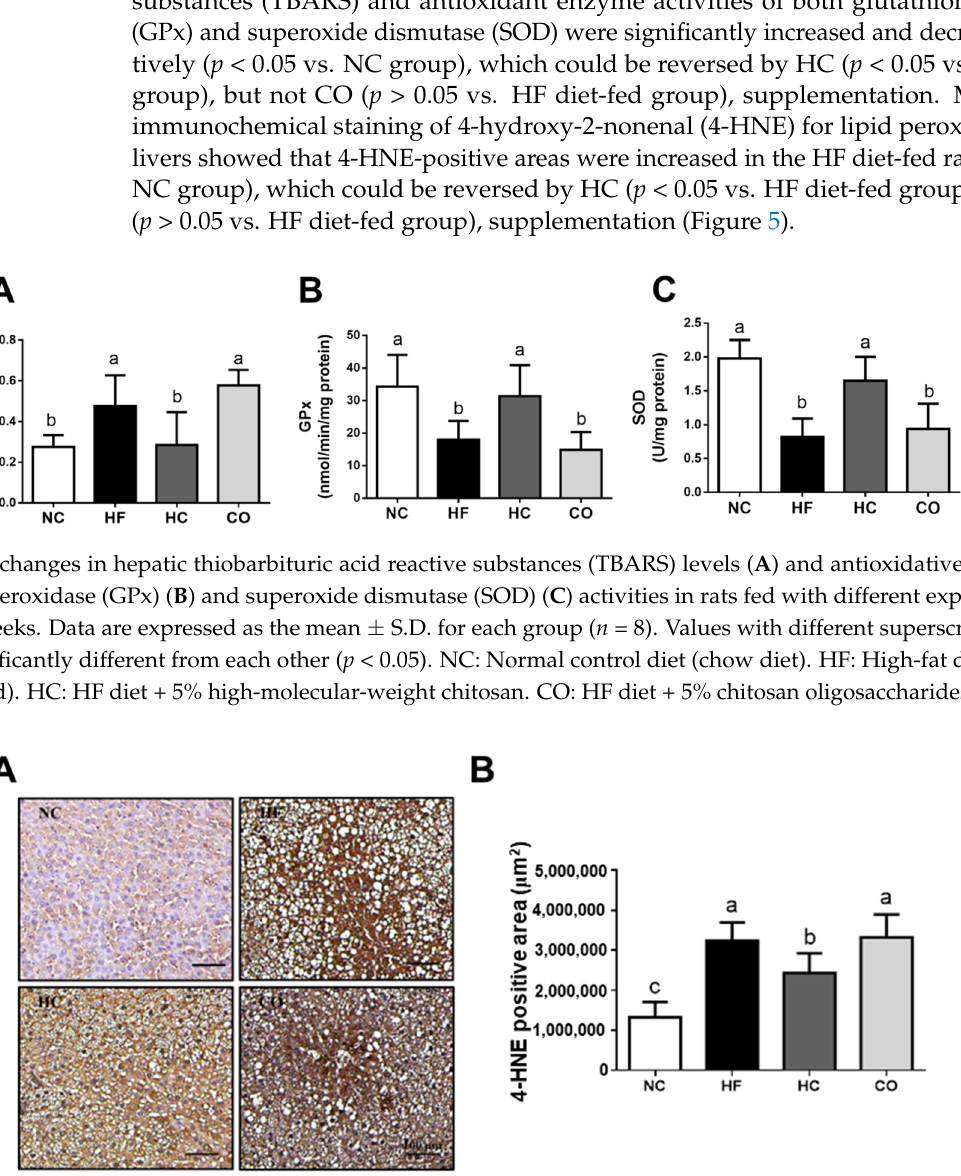
Figure 5. The changes in hepatic immunohistochemical staining for 4-hydroxy-2-nonenal (4-HNE) in rats fed with different experimental diets for 12 weeks. ( A ) Liver sections were immunohistochemically stained with 4-HNE. ( B ) Data are expressed as the mean ± S.D. for each group ( n = 8). Values with different superscript letters (a, b, c) are significantly different from each other ( p < 0.05). NC: Normal control diet (chow diet). HF: High-fat diet (chow diet + 10% lard). HC: HF diet + 5% high-molecular-weight chitosan. CO: HF diet + 5% chitosan oligosaccharides.